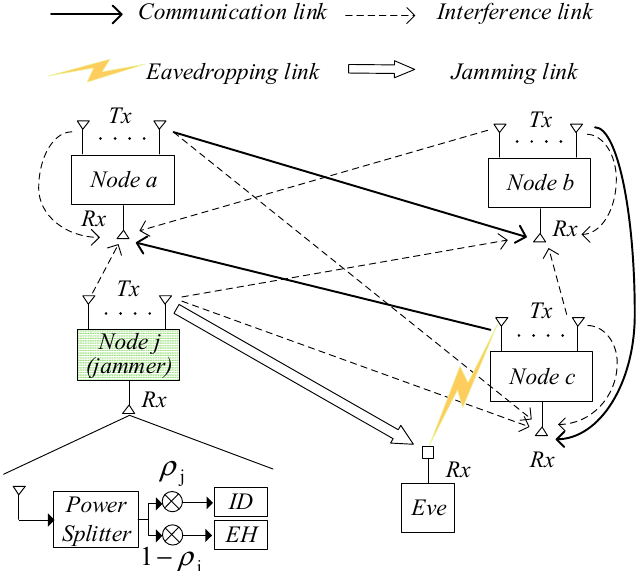
Figure 1. A system model of the simultaneous wireless information and power transfer (SWIPT)-based multi-radio wireless mesh network (WMN) with cooperative jamming.